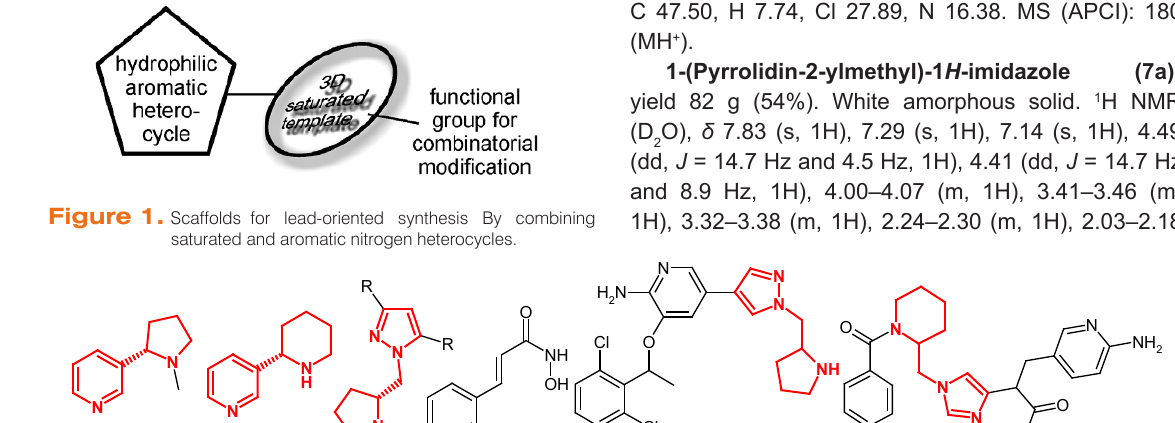
(Table 1 (cid:12)(cid:17)(cid:3) (cid:55)(cid:82)(cid:3) (cid:82)(cid:69)(cid:87)(cid:68)(cid:76)(cid:81)(cid:3) (cid:87)(cid:75)(cid:72)(cid:3) (cid:191)(cid:81)(cid:68)(cid:79)(cid:3) (cid:70)(cid:82)(cid:80)(cid:83)(cid:82)(cid:88)(cid:81)(cid:71)(cid:86)(cid:3) (cid:68)(cid:86)(cid:3) dihydrochlorides, 6 – 11 (0.05 mol) were taken up in 10% HCl in dioxane (50 mL) and evaporated to dryness.